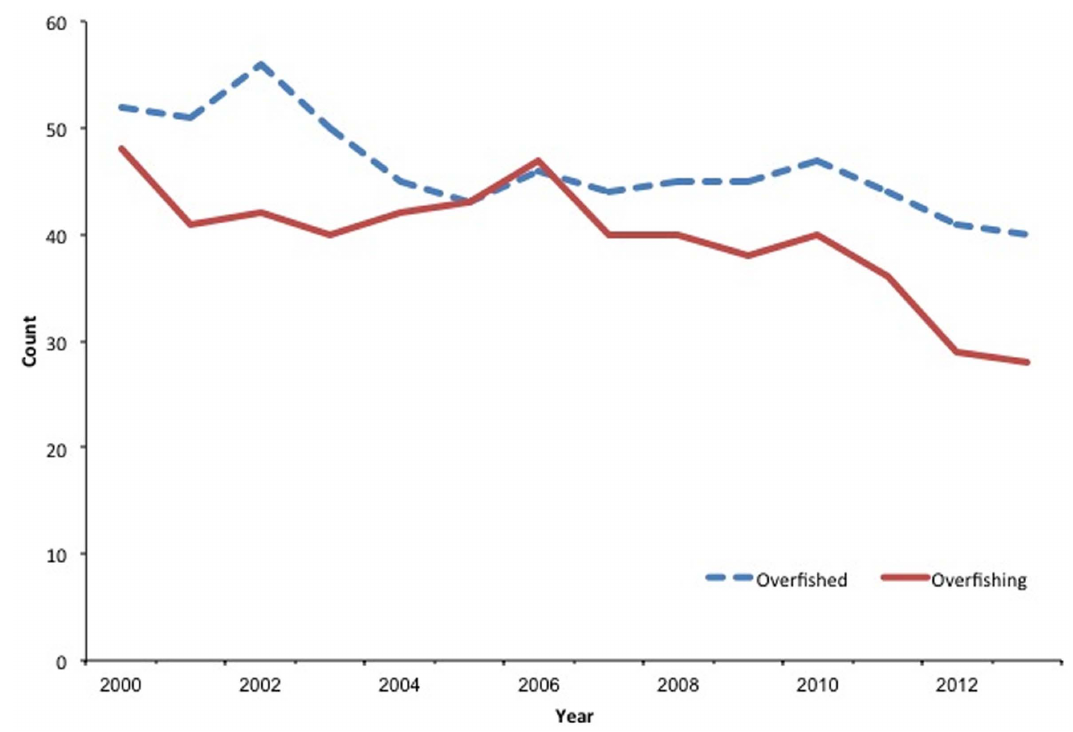
Figure 5. Between 2000 and 2013, overfishing determinations declined from 48 to 28 (a 41% reduction) while overfished determinations declined from 52 to 40 (a 23% reduction).